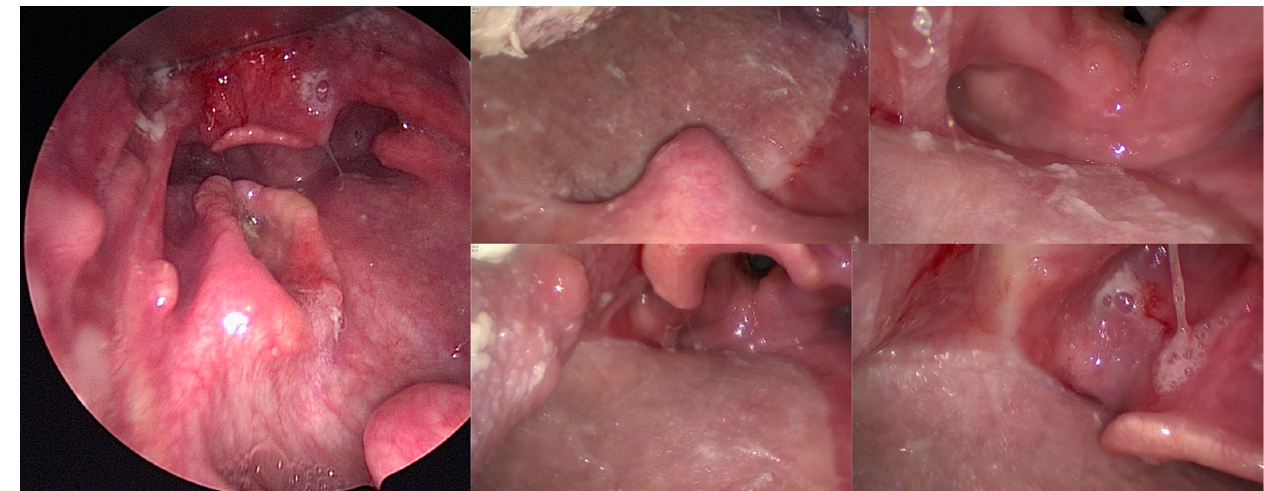
Figure 2. Endoscopic views of a 70-year-old patient with a 39 mm T2N0 p16-negative oropharyngeal carcinoma of the posterior pharyngeal wall who underwent transoral robotic surgery for resection of the posterior and lateral pharyngeal wall, bilateral neck dissection, reconstruction with a thin anterolateral thigh free flap, and postoperative radiotherapy. Forty-four months after the surgery, he was still alive and disease-free, with a normal oral diet and a very satisfactory quality of life.